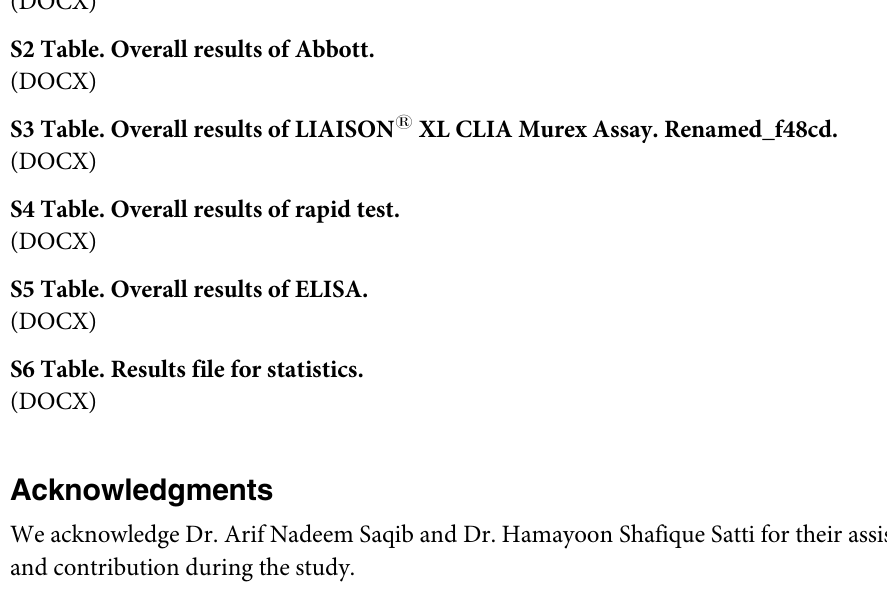
S1 Table. Comparison of four assays for detection of HBV DNA. S2 Table. Overall results of Abbott. S3 Table. Overall results of LIAISON 1 XL CLIA Murex Assay. Renamed_f48cd. S4 Table. Overall results of rapid test. S5 Table. Overall results of ELISA. S6 Table. Results file for